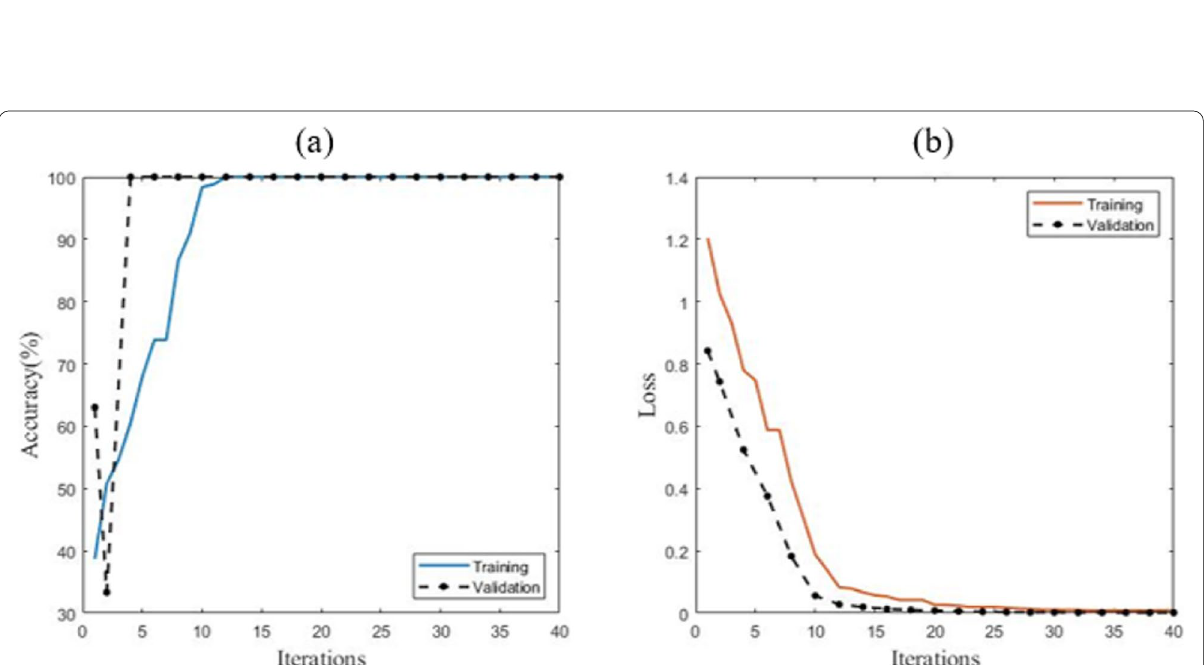
Fig. 6 Training stage: ( a ) performance and ( b ) loss evaluation of the proposed CNN architecture using CWT TF